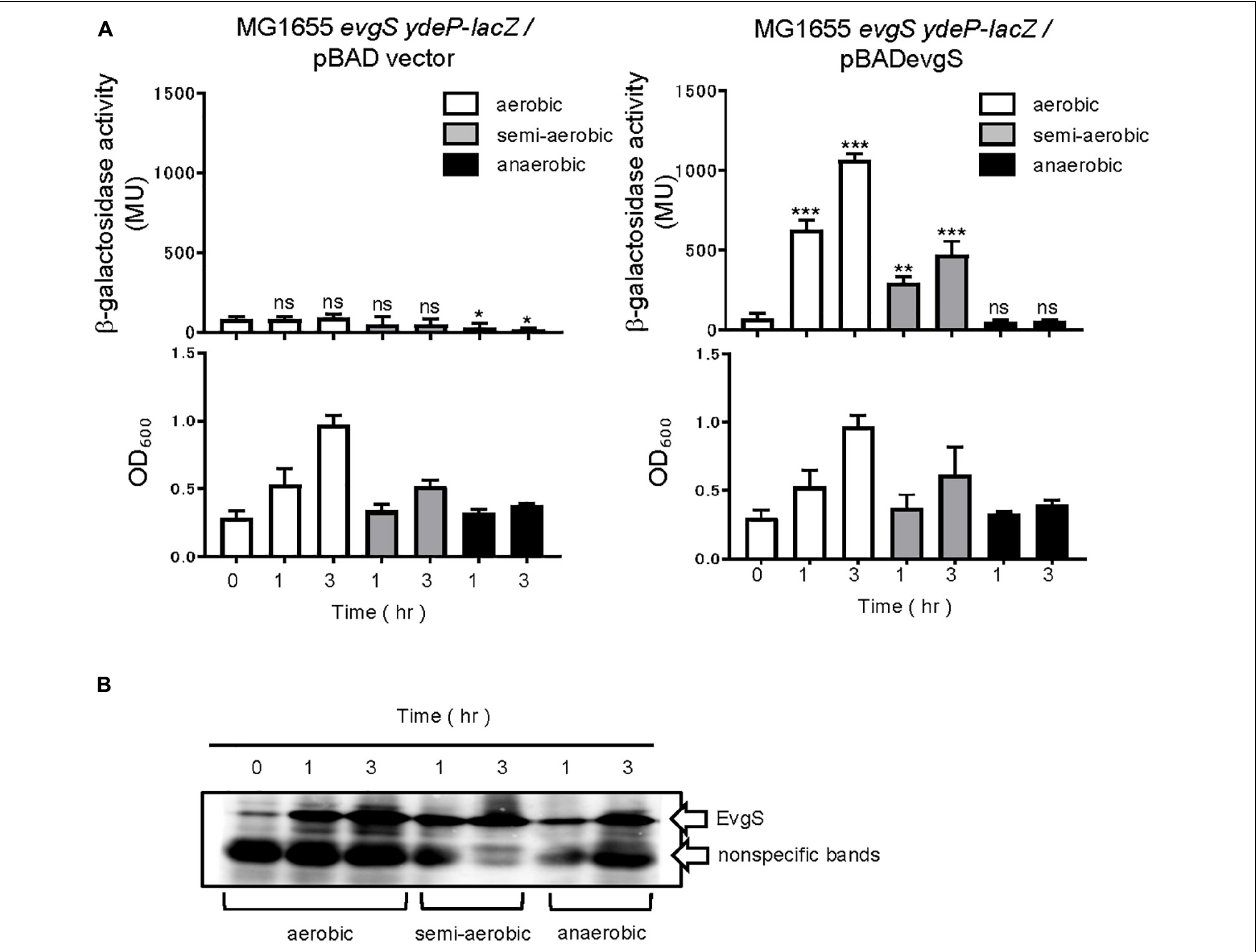
FIGURE 2 | Response to aeration is EvgS-dependent. (A) Activity of the ydeP-lacZ reporter in different culturing conditions (upper panels). Cells were grown in EvgS-activation medium with 0.02% arabinose under aerobic (white bars), semi-aerobic (gray bars), or anaerobic condition (black bars) at 37 ◦ C. Cell growth indicated by optical density at 600 nm is shown in the lower panels. Data represent the average of three biologically independent replicates. Error bars indicate the standard deviation, and statistical analyses of each redox condition group were performed as described in Figure 1 . ns, not significant; *0.01 ≤ p < 0.05; **0.001 ≤ p < 0.01; *** p < 0.001. (B) EvgS expression in MG1655 evgS ydeP-lacZ/ pBADevgS. Immunoblotting analysis using anti-EvgS antiserum for EvgS detection is shown. Samples are from the same culture as those subjected to reporter